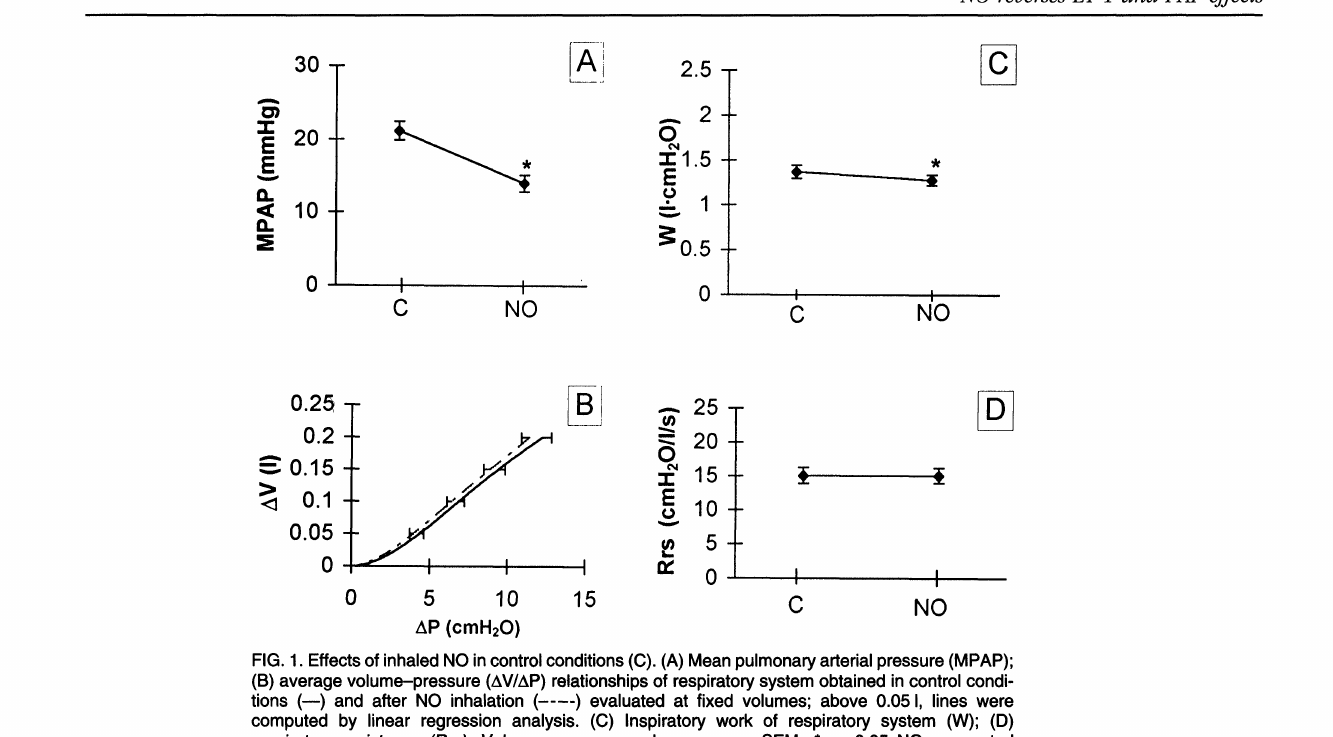
FIG. 1. Effects of inhaled NO in control conditions (C). (A) Mean pulmonary arterial pressure (MPAP); (B) average volume-pressure (AV/AP) relationships of respiratory system obtained in control condi- tions (m) and after NO inhalation (----) evaluated at fixed volumes; above 0.05 lines were computed by linear regression analysis. (C) Inspiratory work of respiratory system (W); (D) respiratory resistance (Rrs). Values are expressed as means SEM. *p < 0.05 NO vs. control